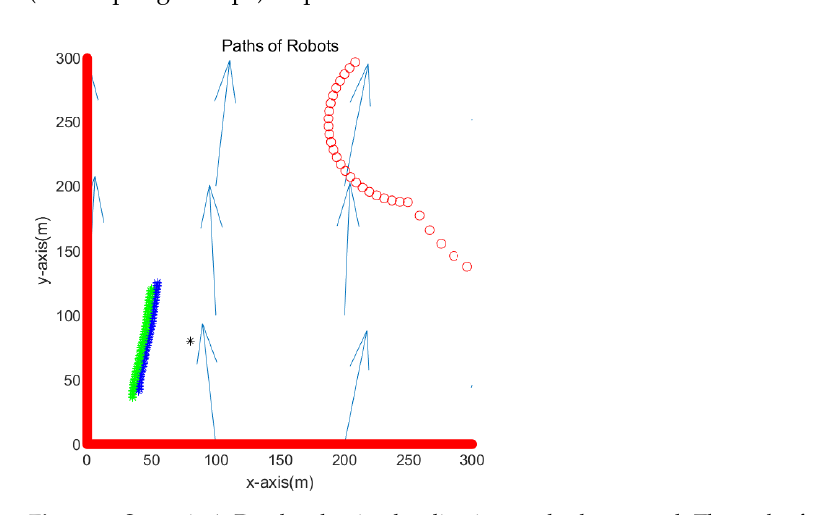
Figure 7. Scenario 1. Dead reckoning localization methods are used. The path of one robot is depicted with blue asterisks, and that of another robot is depicted with green asterisks. The goal is marked with a black asterisk.